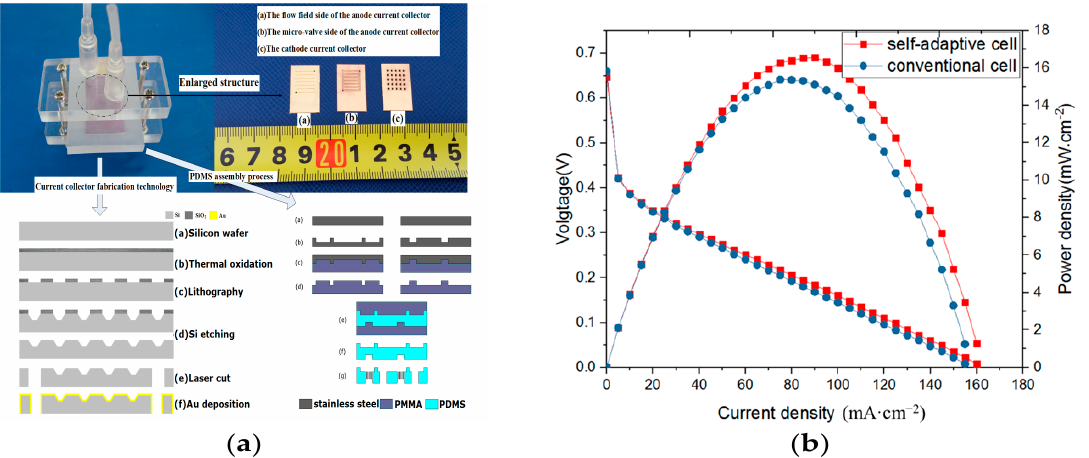
Figure 8. The micro DMFC and the performances between the cell with a microvalve and a conventional cell . (a) The cell fabrication structure, (b) I-V and I-P curve.